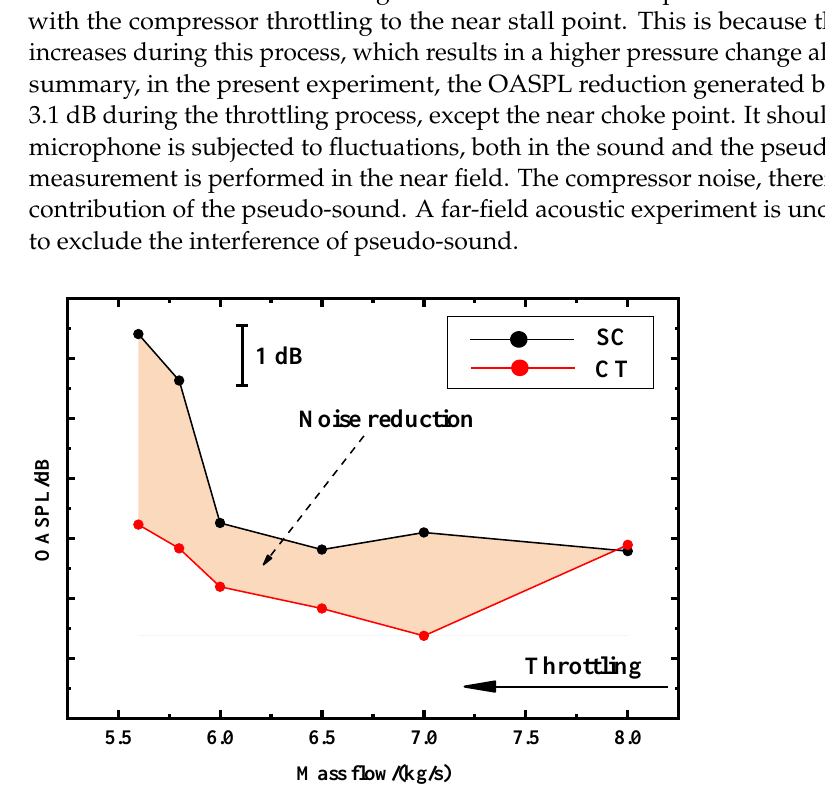
Figure 7. OASPL of the compressor, with and without CT, during the throttling